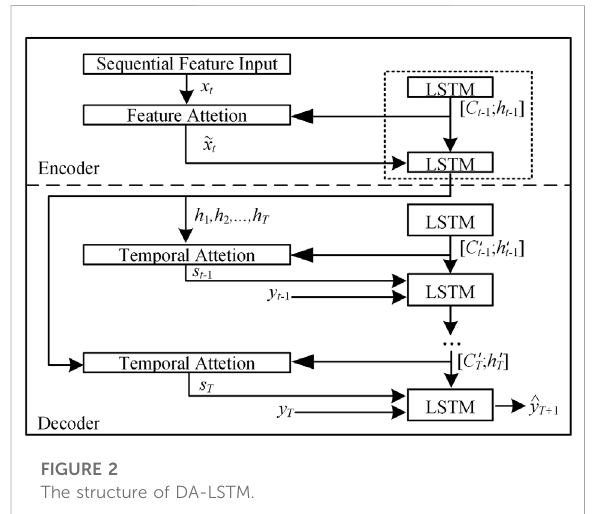
FIGURE 2 The structure of